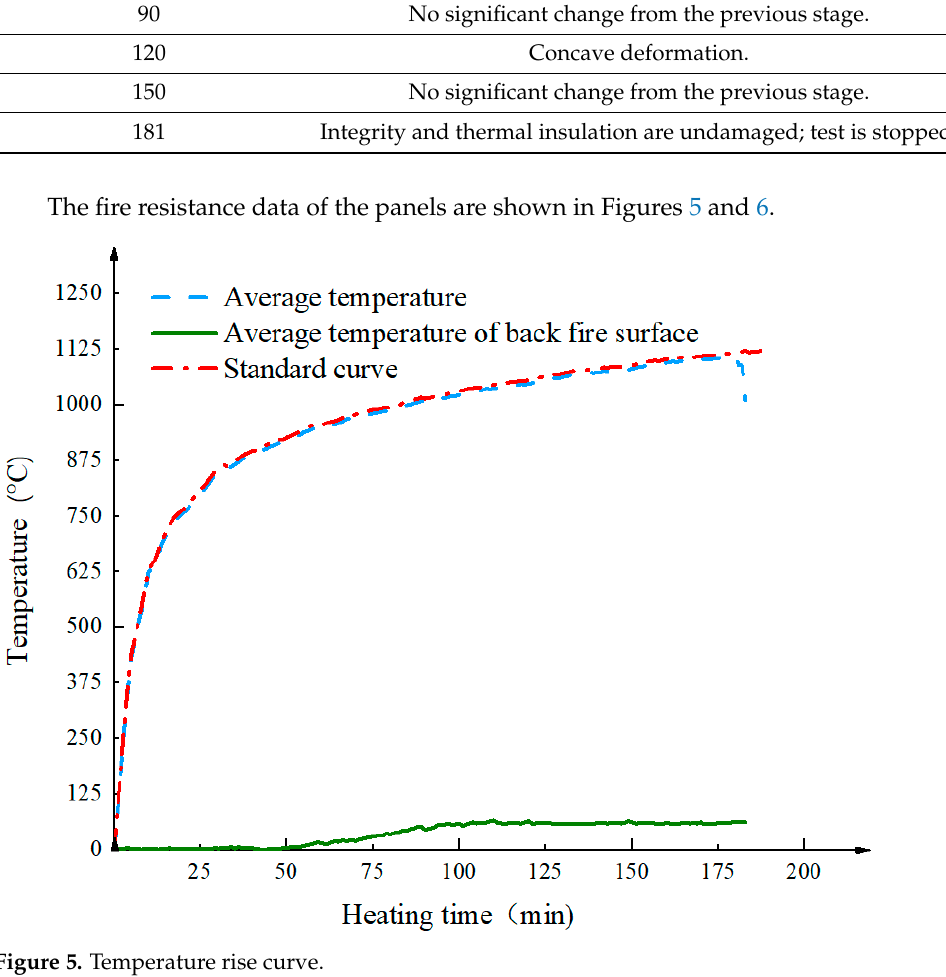
Figure 6. Pressure curve at 500 mm below the furnace roof. 3.1.2. The Stress Test of the Panel